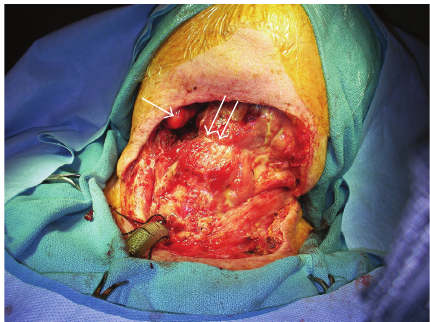
Figure 4: Intraoperative image taken after repeat debridement. Note: exposed submandibular gland on right side (single arrow) and exposed hyoid bone (double